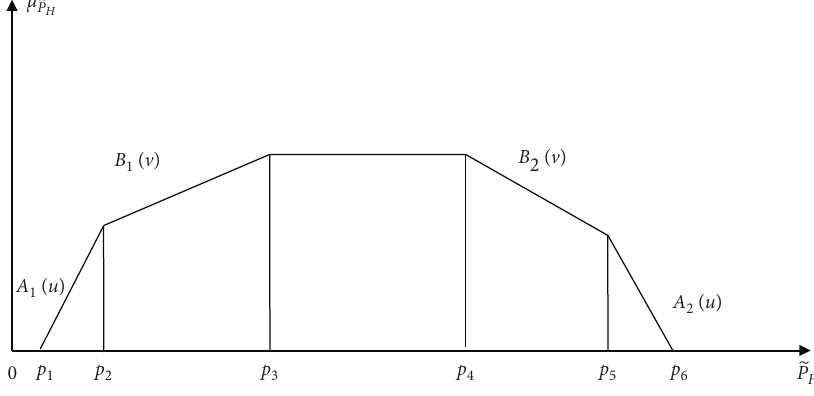
Figure 1: Graphical representation of a hexagonal fuzzy